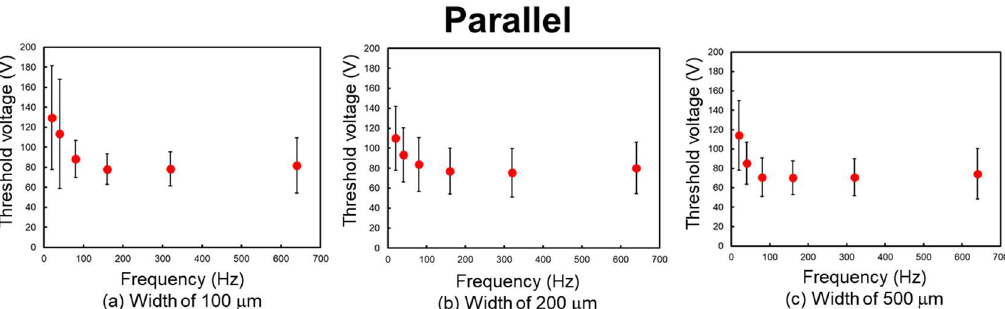
Figure 7. Relationship between frequency and threshold voltage. The finger was positioned parallel to the length of the electrodes, as shown in Figure 5c. ( a ) Width of 100 μm. ( b ) Width of 200 μm. ( c ) Width of 500 μm.